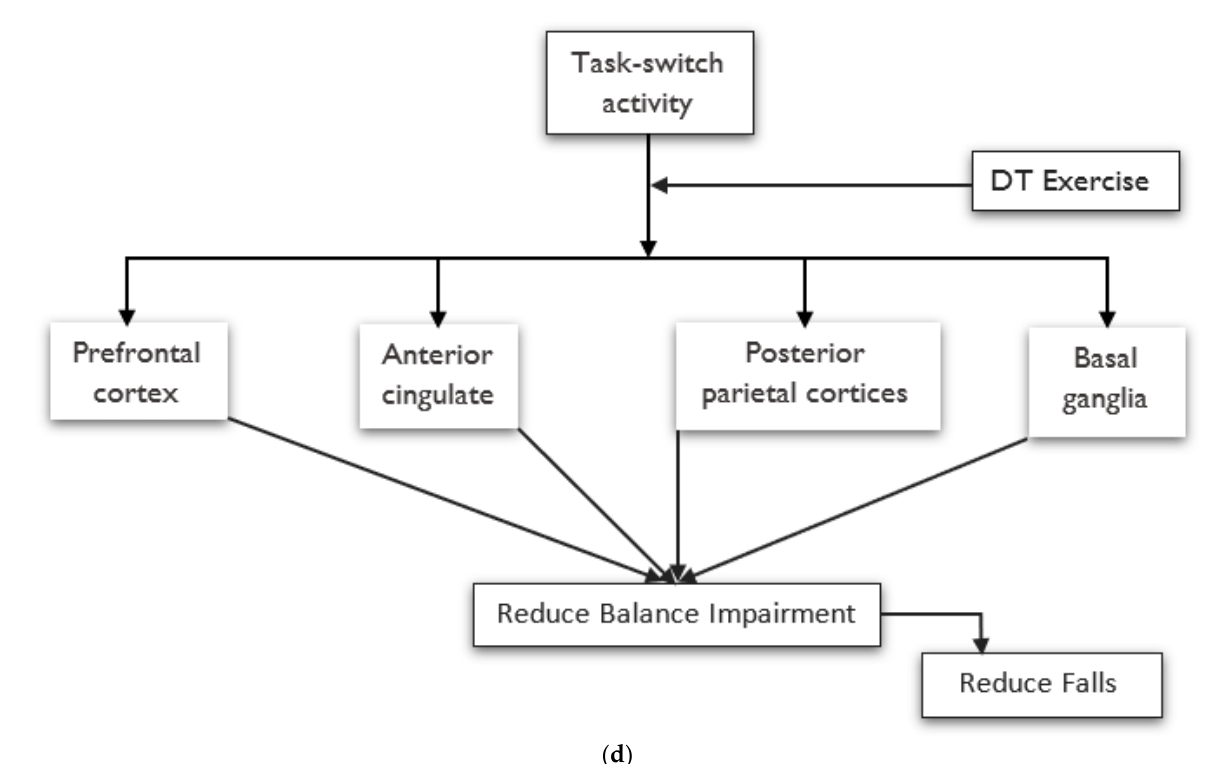
Figure 3. ( a ) Concept of neurophysiological phenomenon of attention theory for DT intervention; ( b ) Concept of executive function approach in application of DT Intervention; ( c ) Concept of Multicomponent Training Approach of DT Intervention; ( d ) Concept of Working Memory Model in Application of DT Intervention.